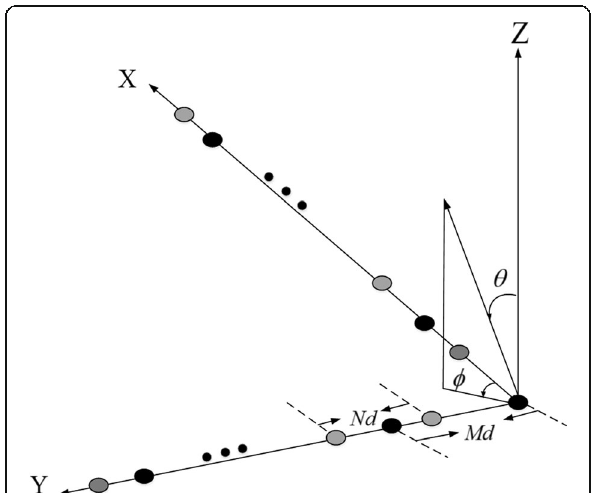
Fig. 3 The L-shaped array consists of co-prime arrays. It shows a plane L-shaped array consists of two co-prime subarrays where an M + N − 1-element arranged along the X -axis and an M + N − 1- element arranged along the Y